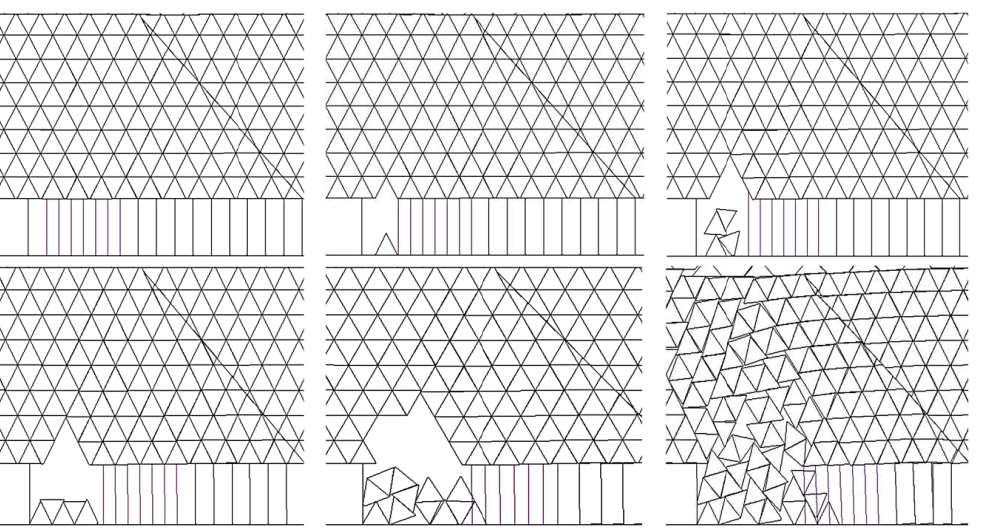
Figure 7. The state of the model within the first stages of the simulated exploitation.